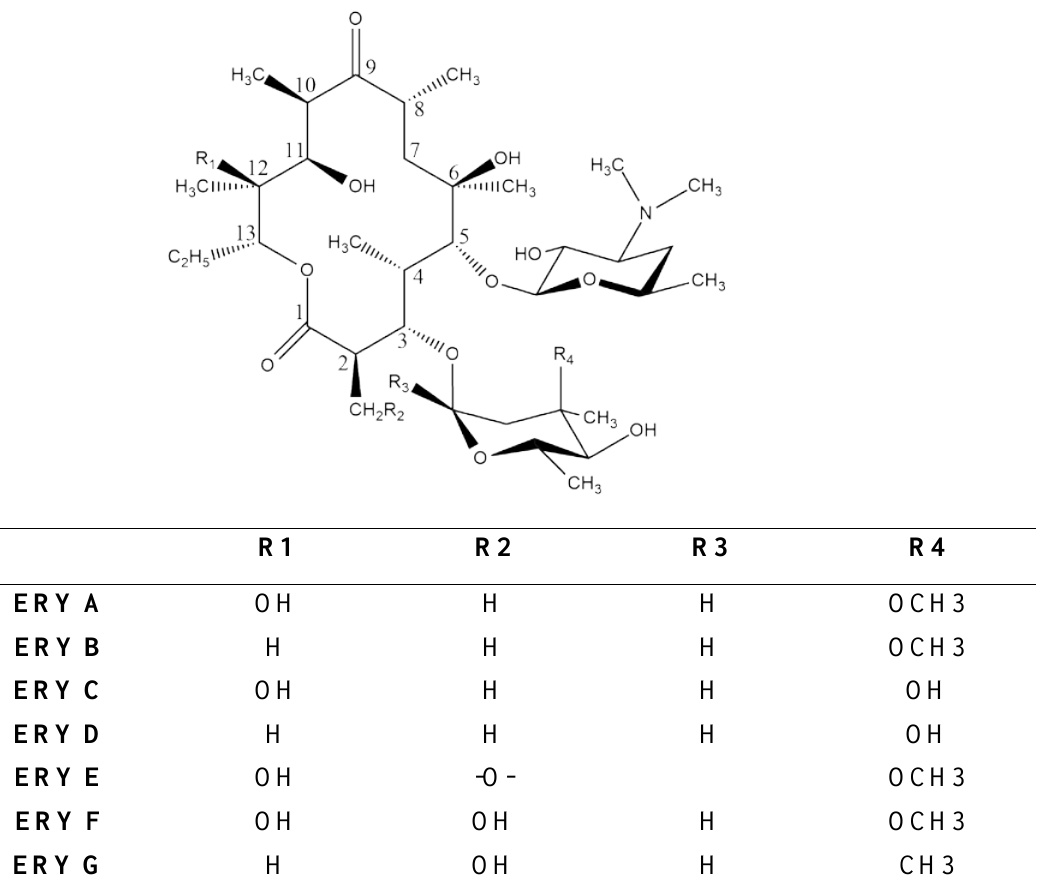
Figure 1 . Chemical structures of the erythromycin group. Figure 1. Chemical structures of the erythromycin